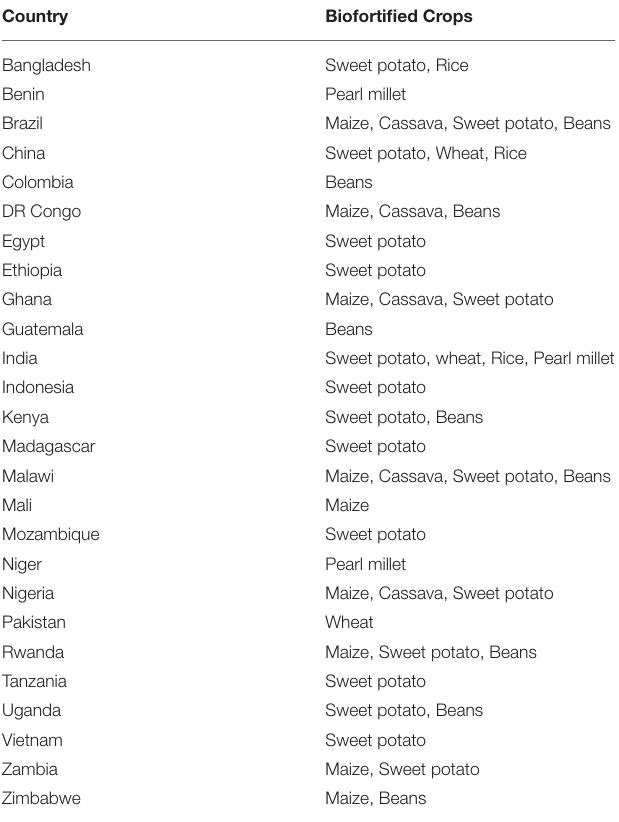
TABLE 2 | Priority countries-primary crops combination.